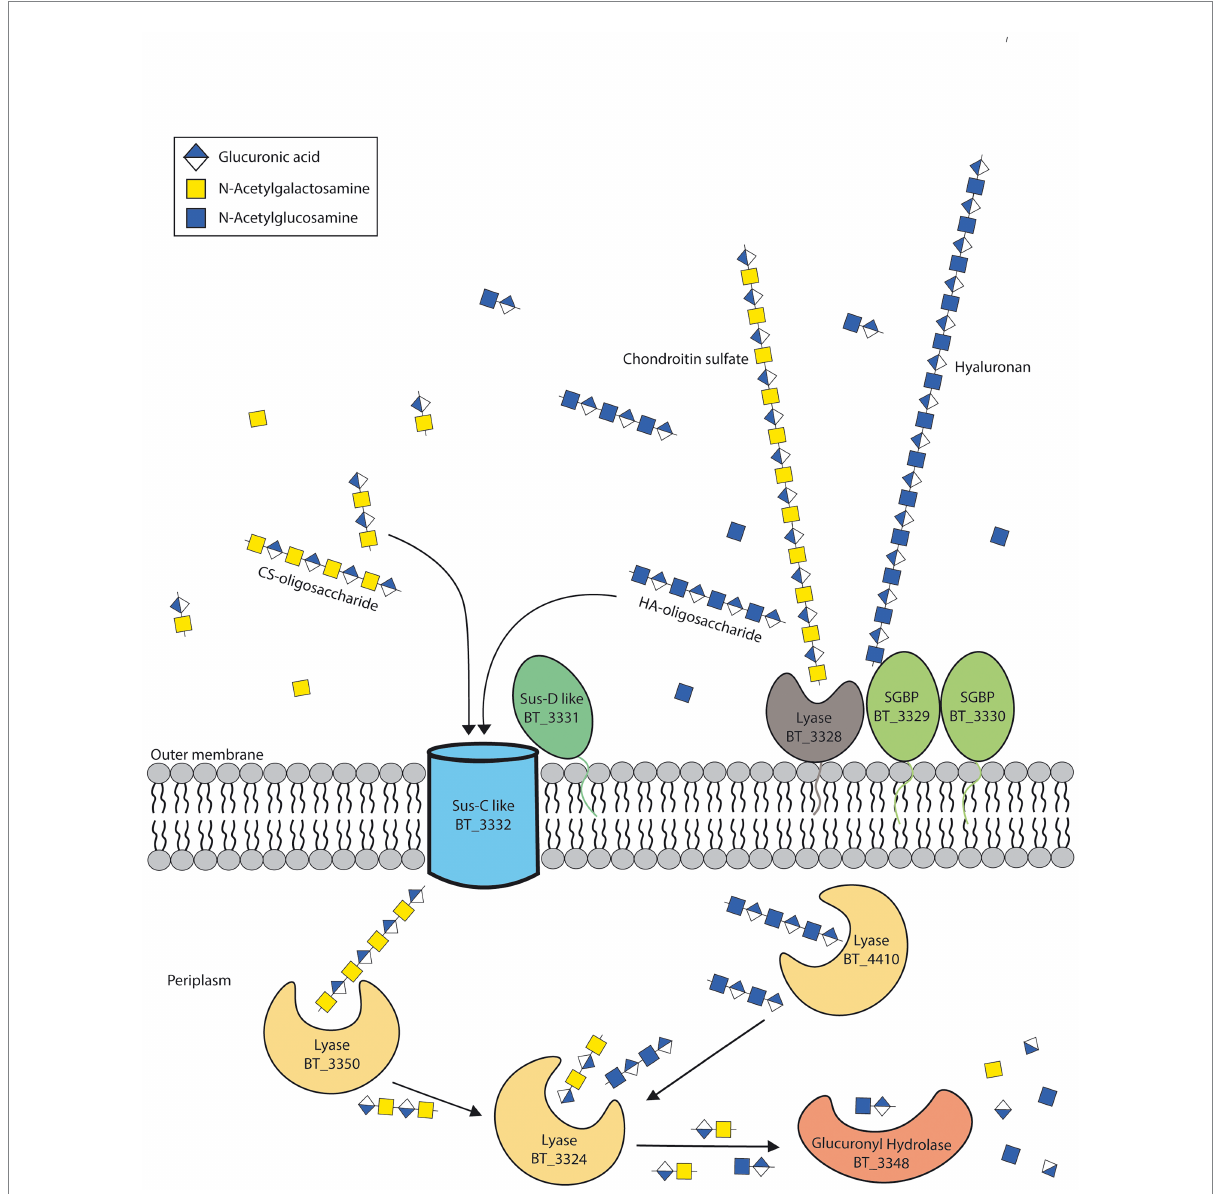
FIGURE 5 Suggested model for hyaluronan breakdown. Based on our results, we propose that the lyase BT_3328 and surface glycan binding proteins (SGBP) BT_3329 and BT_3330 are required to cleave hyaluronan (HA) before transport and further degradation in the periplasm. Adapted from Ndeh et al.